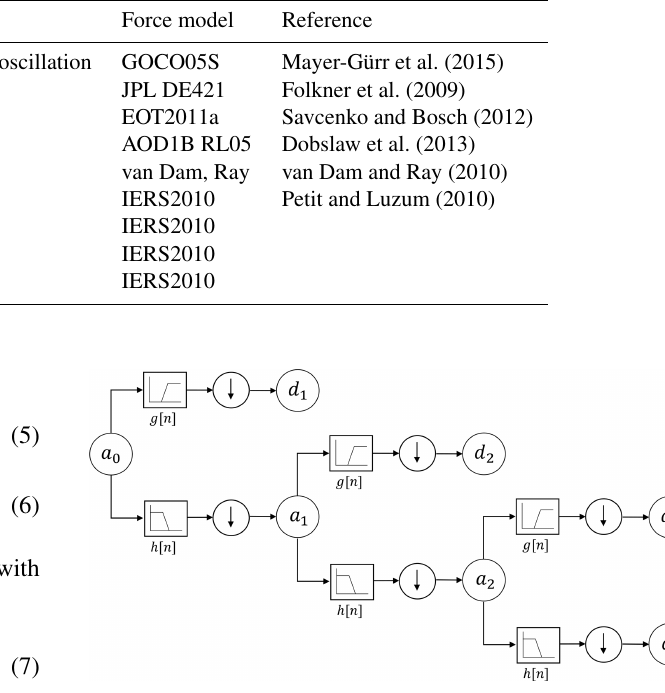
Figure 2. Three-level MRA decomposition tree, consisting of a high-pass filter g [ n ] and a low-pass filter h [ n ] followed by a down- sampling operator at each